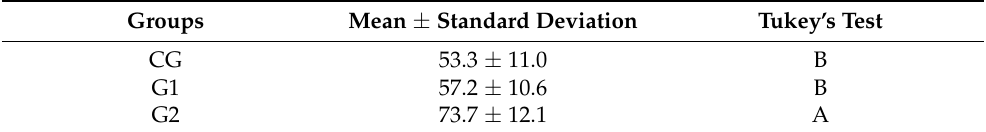
Table 5. Mean and standard deviation for the contact angle with Tukey’s test ( α = 0.05) for the glaze.